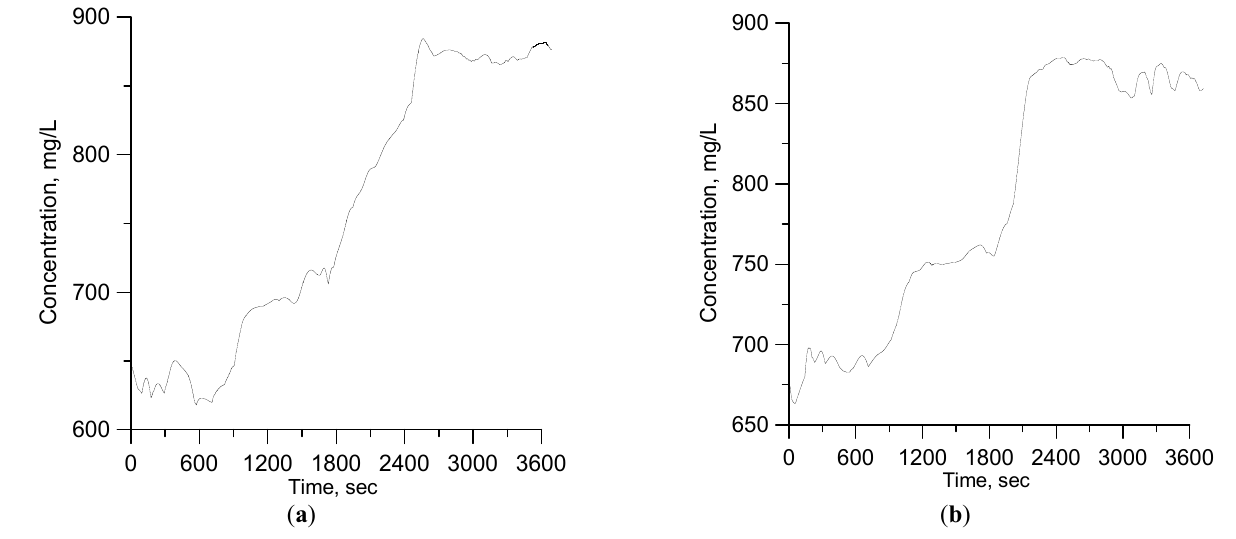
Figure 9. Temporal evolution of the mineralization field of withdrawn water in the presence of bottom barriers at the flow rate of water intake through a single intake head of 4 m 3 /s (in the vertical section along the stream ( a ), across the stream ( b )). The velocity of the river flow varies linearly from 0 m/s to 0.1 m/s in 1 h.